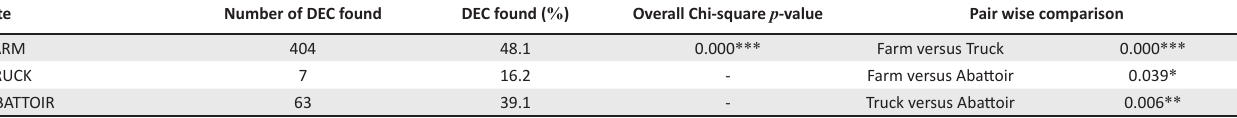
TABLE 3-A1: Prevalence of diarrheagenic E. coli along the pig production continuum.